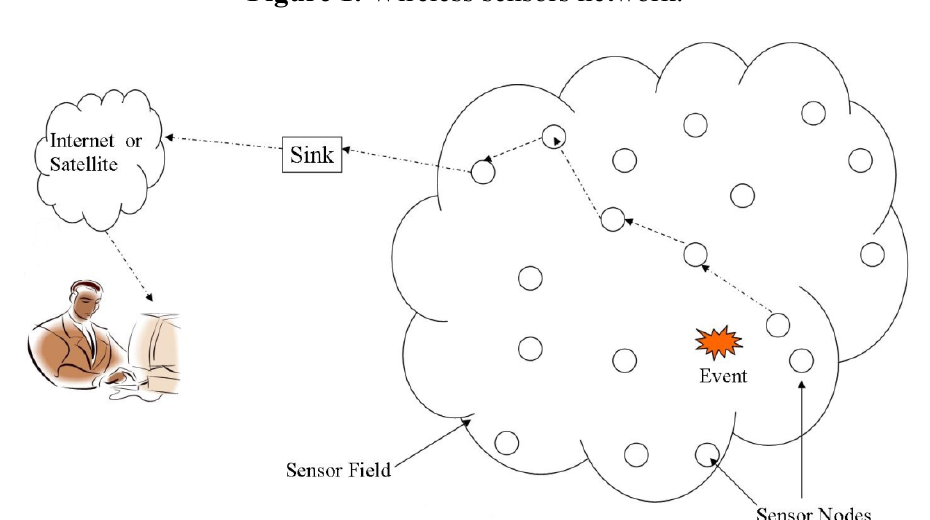
Figure 1. Wireless sensors